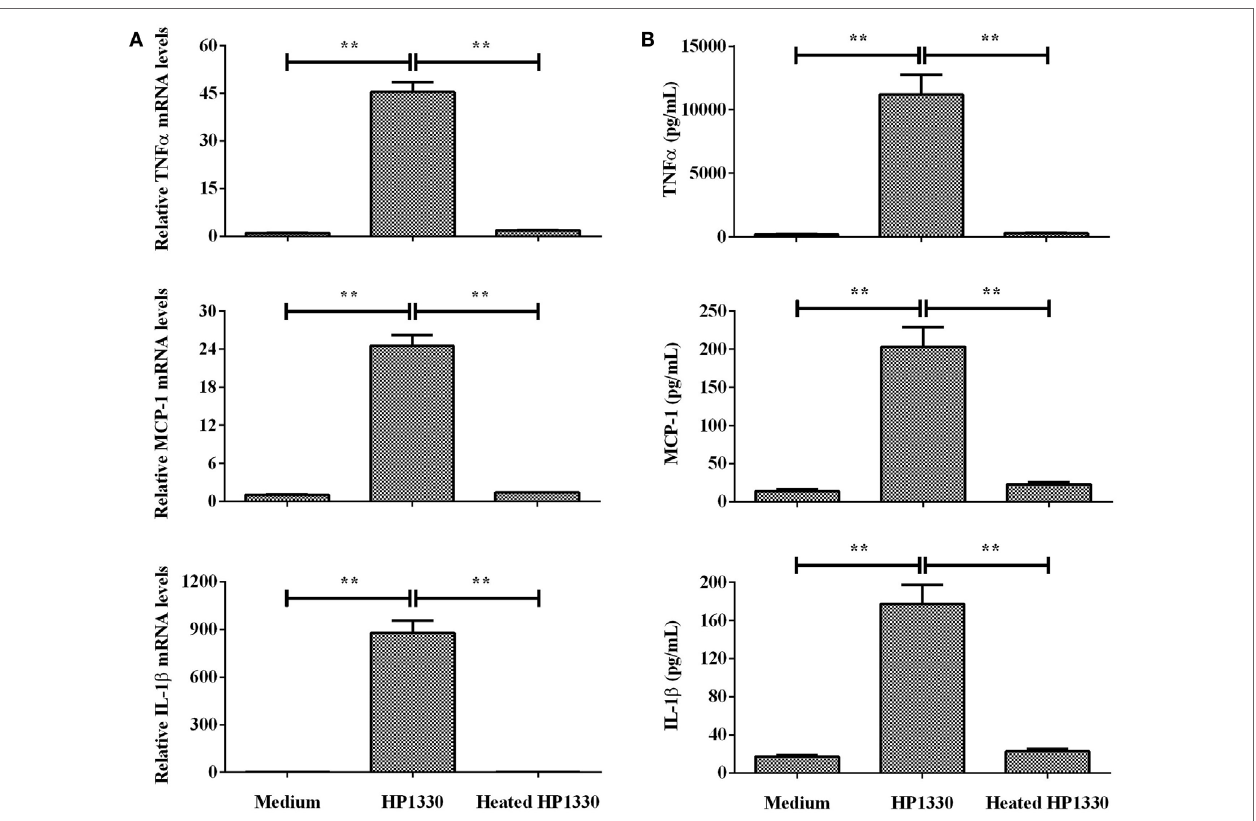
FigUre 3 | Effect of heat inactivating HP1330 on pro-inflammatory cytokine induction. RAW 264.7 macrophages were stimulated with HP1330 (10 µg ⋅ ml − 1 ) and pretreated HP1330 (10 µg ⋅ ml − 1 , 100°C for 10 min). (a) The mRNA levels of TNF- α , MCP-1, and IL-1 β were examined by qRT-PCR, (b) and the cytokine protein levels in the culture supernatants were examined by enzyme-linked immunosorbent assay. The bars represent the SEMs, based on three independent experiments. ** P <